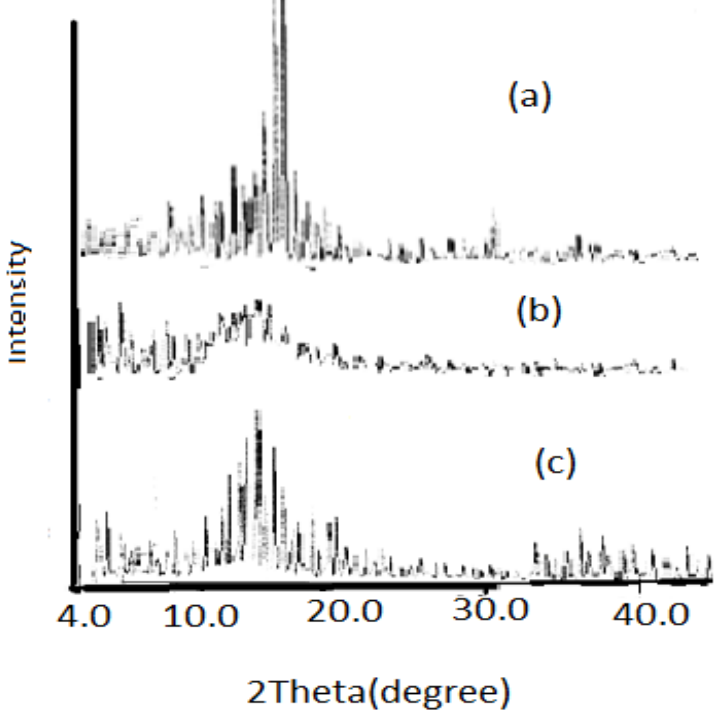
Figure 11. XRD pattern for PP. ( a ) blank, ( b ) grafted, and ( c ) amidoxaminated.